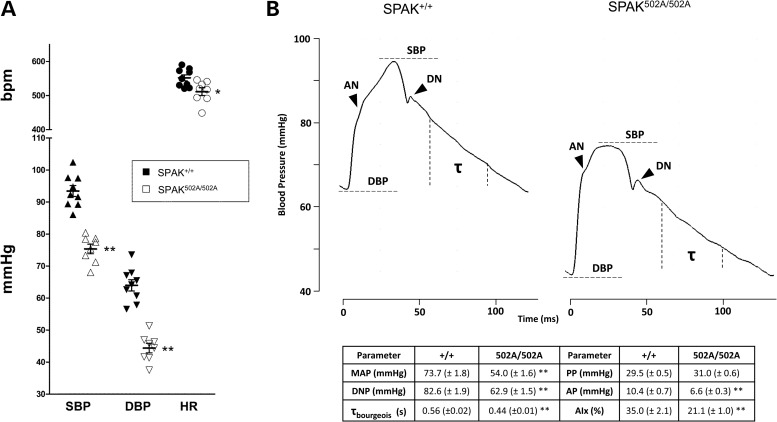
Blood pressure and pressure waveforms of SPAKL502A/L502A mice. (A) Intravascular carotid measurements of systemic systolic blood pressure (SBP) and diastolic blood pressure (DBP), and heart rate (HR) determined by ECG R-R wave interval in mice under general anaesthesia. (B) Pulse waveform analysis reveals no change in pulse pressure (PP) (SBP–DBP) but does show decreased augmentation pressure (AP) (SBP–anacrotic notch [AN] pressure), dicrotic notch (DN) pressure and MAP (1/3 × SBP + 2/3 × DBP) in the SPAKL502A/L502A versus wild type. This hypotensive phenotype is in part owing to changes in vascular contractility in SPAKL502A/L502A mice as evidenced by their lower augmentation index (AIx) [AP/PP], a marker of arterial stiffness, and is further supported by a decrease in their diastolic pressure decay time constant (τbourgeois) (1/slope of diastolic pressure decay; measured 30 ms after DN and 20 ms before end DBP), a surrogate marker of decreased vascular resistance. Bars are mean ± SEM, n = 8–9. Significant differences from the SPAK wild type are shown by: *P < 0.02, **P < 0.001.